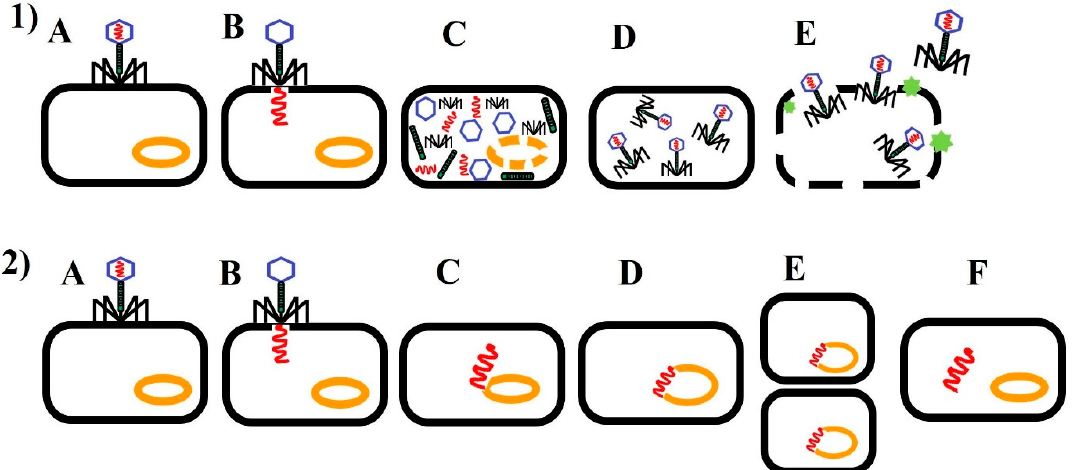
Figure 1. Life cycle of bacteriophage. (1) Lytic cycle. ( A ) Attachment: the phage binds to a receptor on the bacterial cell surface. ( B ) Penetration: the phage inserts its DNA into the bacterial cytoplasm. ( C ) DNA replication and protein synthesis: the phage takes over the bacterial cell functions